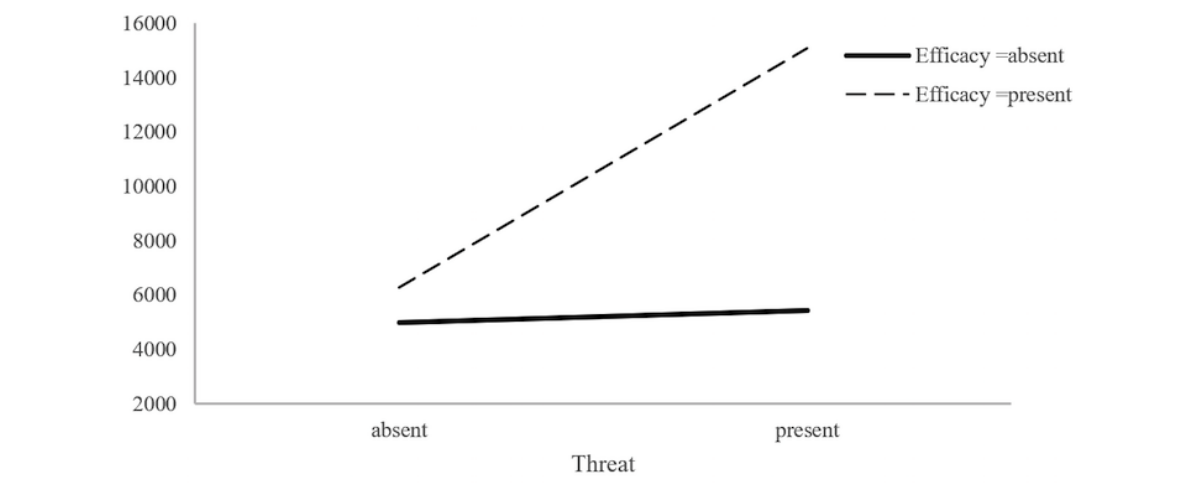
Figure 1. Interaction effect between threat and efficacy upon the number of readings.